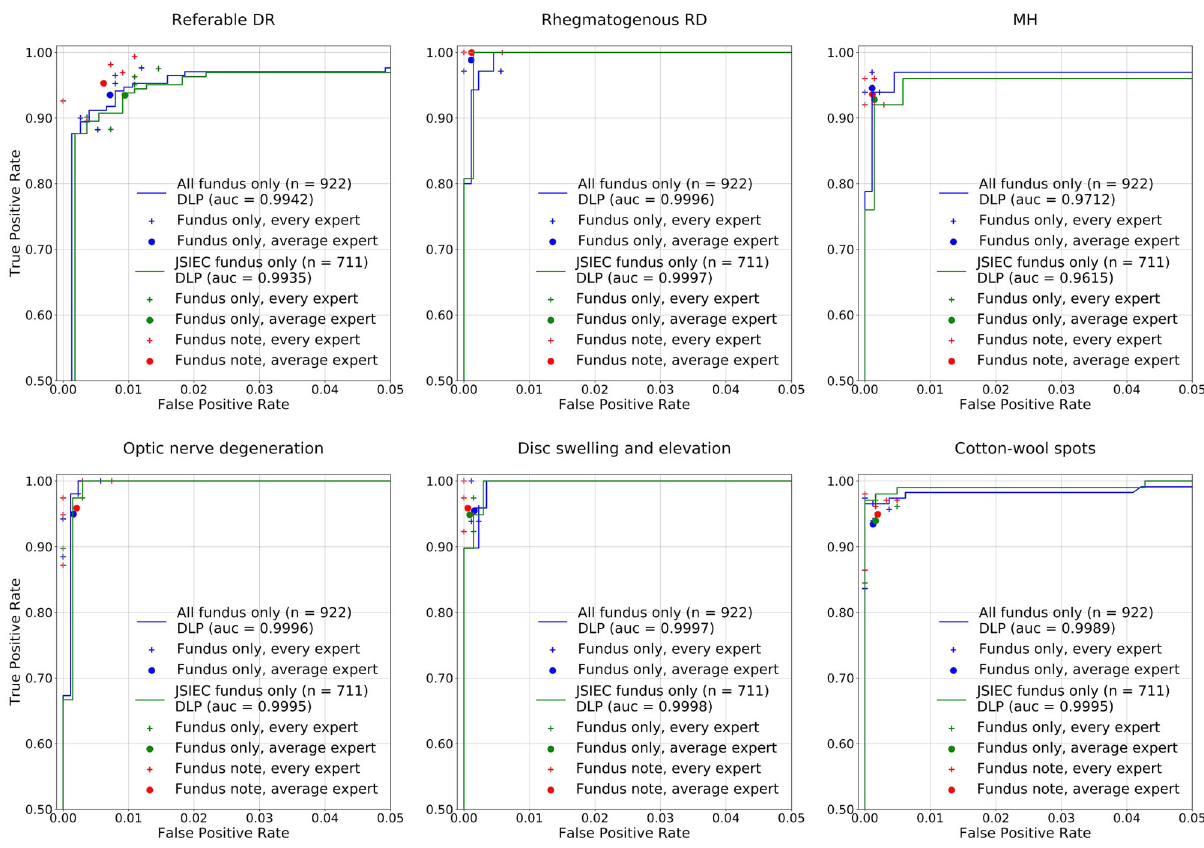
Fig. 3 Performance of DLP in comparative test data set compare to retina experts. Examples of ROC curves and AUC for detecting referable DR, rhegmatogenous RD, ERM, optic nerve degeneration, disc swelling and elevation, and cotton-wool spots in comparative test data set were calculated and plotted (blue curves for all images, and green curves for JSIEC images). Performance of individual retina expert (more than 10 years ’ clinical experiences in the retina specialty) is indicated by the crosses, and averaged expert performance by dots. Blue and green crosses/dots denote performance without patient information and red crosses/dots denote performance with patient information. Source data are provided as a Source Data fi